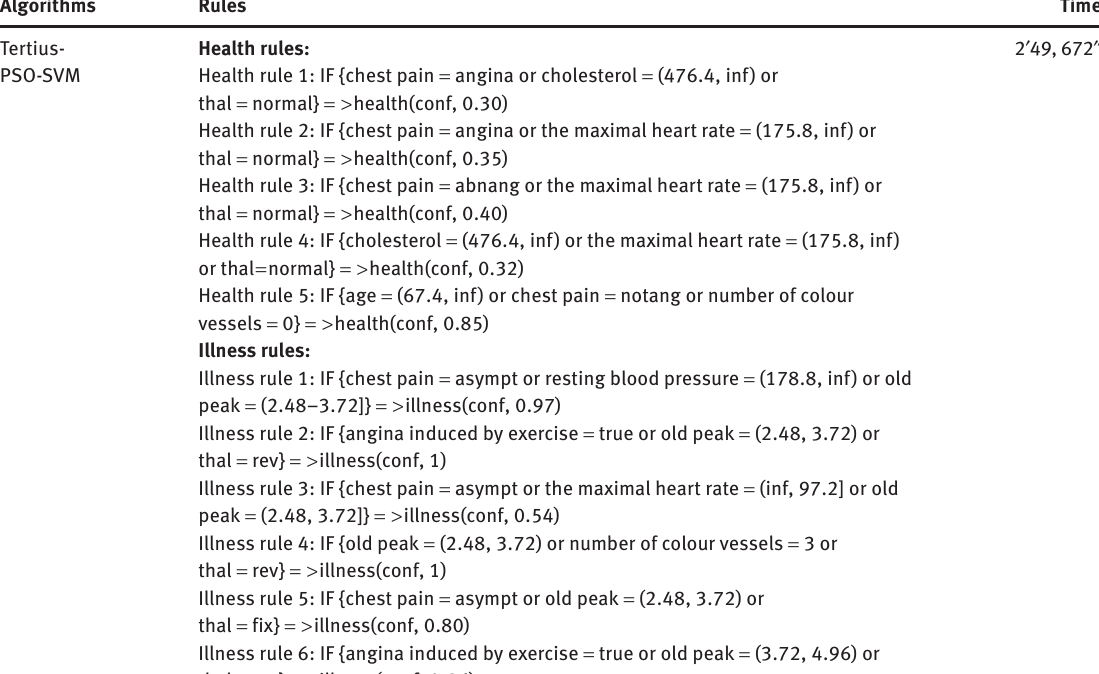
Table 3: Health and Illness Rules Extracted Using the Tertius Algorithm.